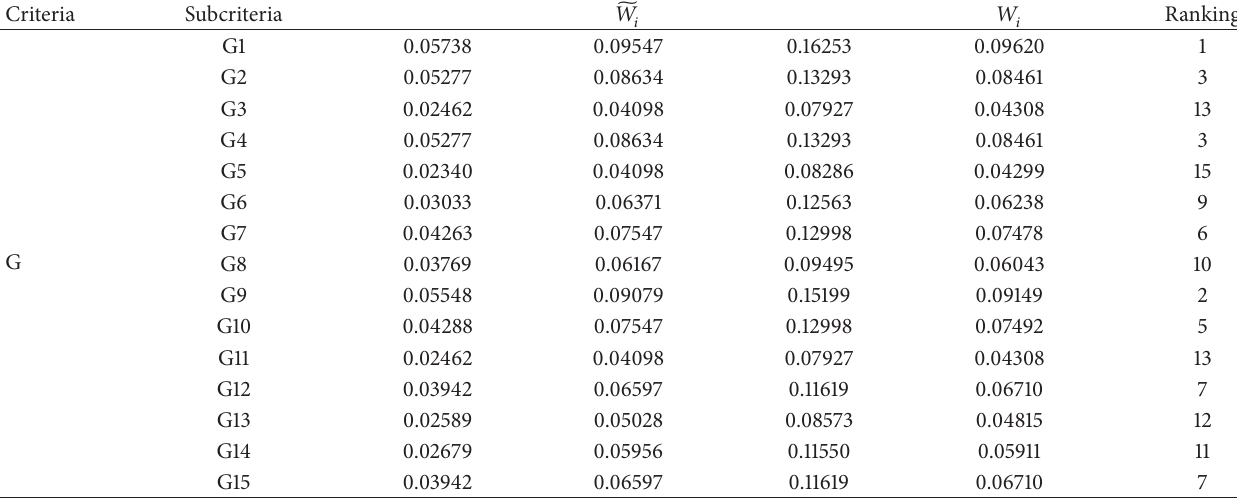
Table 10: Fuzzy and crisp weights and ranking scores for subcriteria in general group.